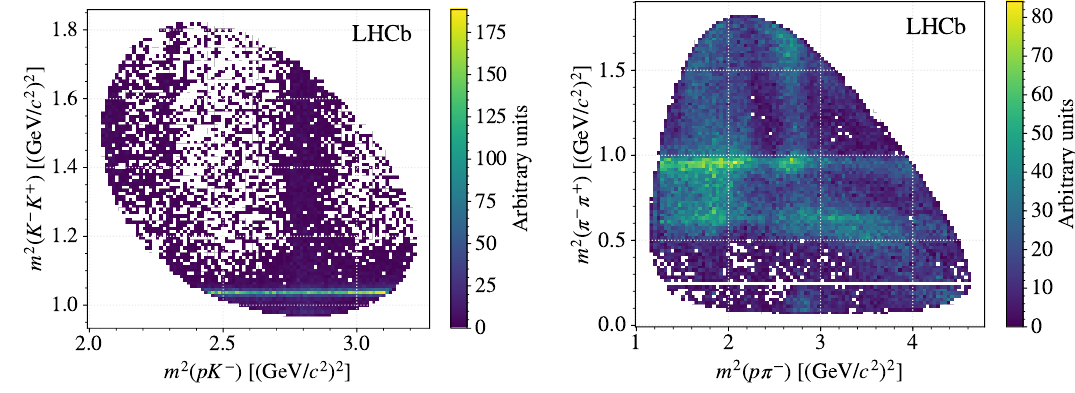
Figure 3 . Background-subtracted and e(cid:14)ciency-corrected (cid:3) + (right) data in the m 2 ( ph (cid:0) ){ m 2 ( h (cid:0) h + ) plane, integrated across all data-taking